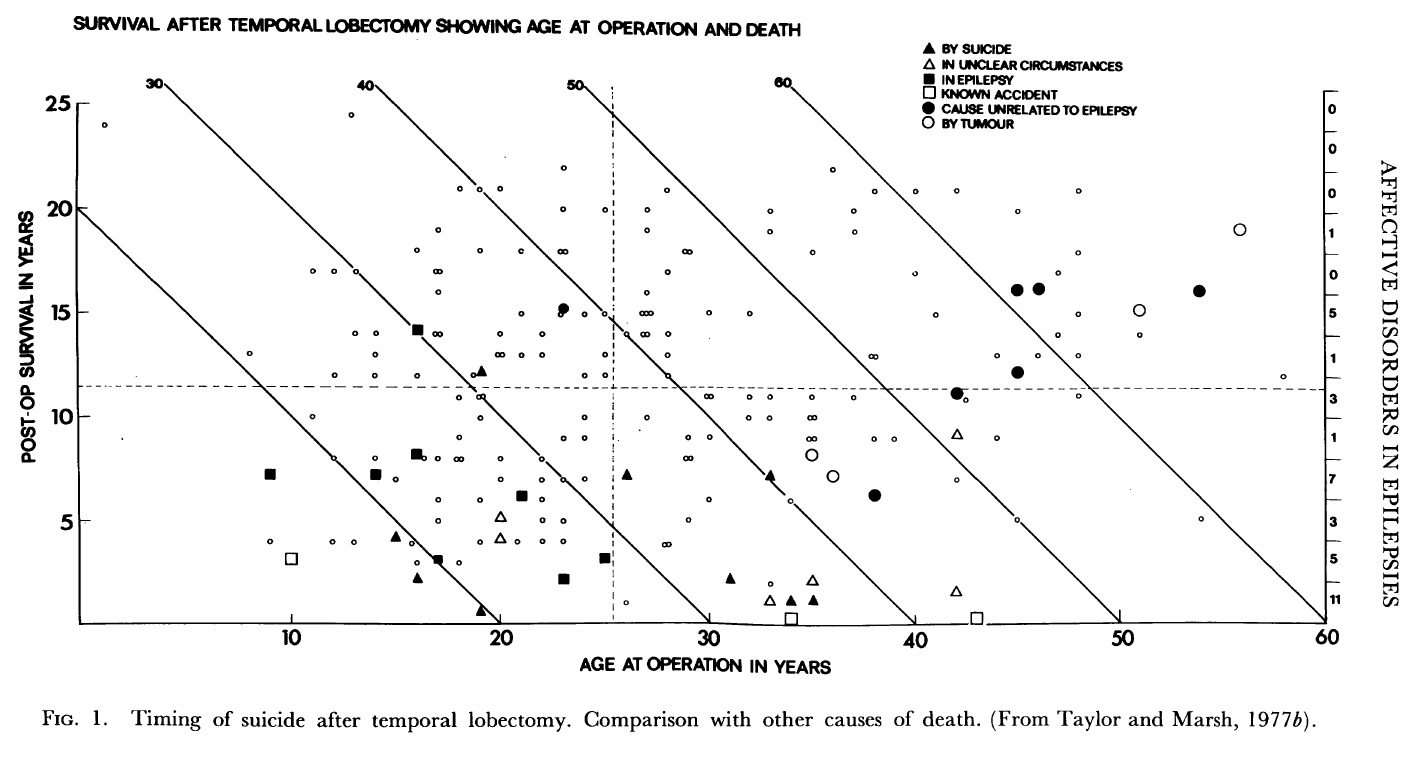
FIG. l. Timing of suicide after temporal lobectomy. Comparison with other causes of death. (From Taylor and Marsh,